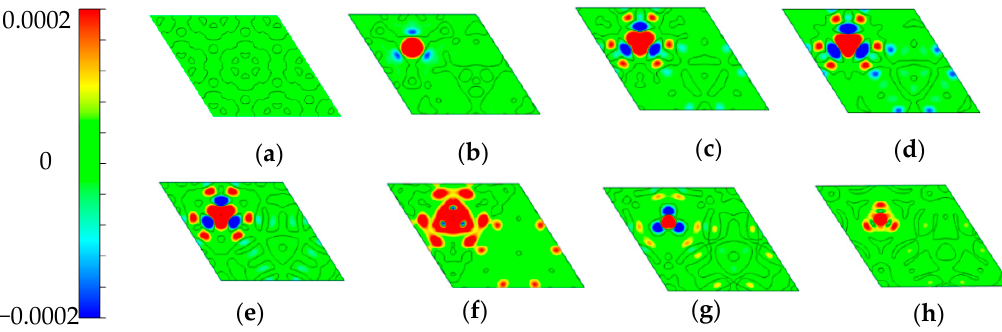
Figure 4. Spin density distributions for different doped systems. ( a – h ) correspond to pure GaP 3 , Ti–, V–, Cr–, Mn–, Fe–, Co– and Ni–doped, respectively. The 2D planes are determined by three Ga atoms and the dopants for the doped system, three P atoms for pure GaP 3 .